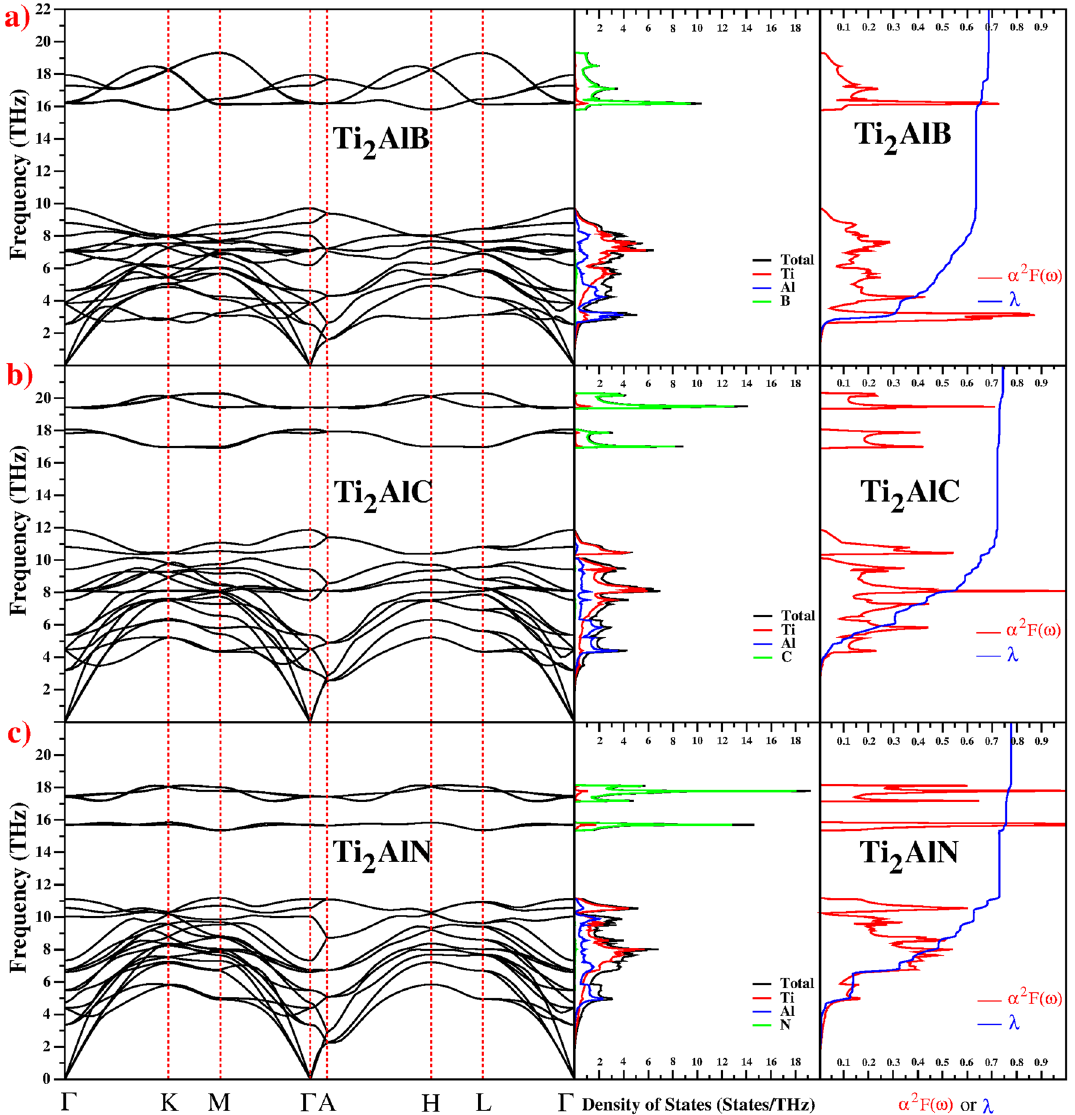
Figure 5. Phonon dispersion curves, total, partial vibrational density of states and the calculated electron- 2 F (ω) phonon spectral function α (red line) and the variation of the electron–phonon coupling parameter (blue line) with rising frequency (cid:31) ( ω ) of ( a ) Ti 2 AlB, ( b ) Ti 2 AlC and ( c ) Ti 2